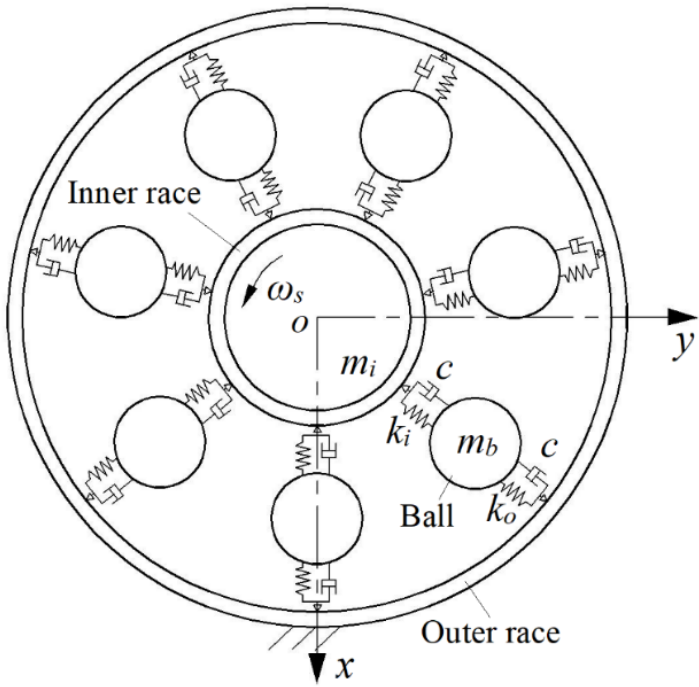
Figure 4. Diagram of the developed dynamic model of ball